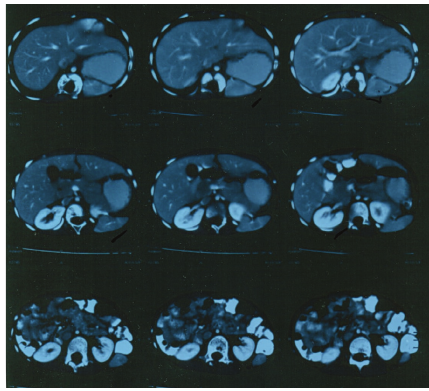
Figure 3: CT scan showing severely hypoplastic posterior abdom- inal muscles (erector spinae, iliocostalis, and latissimus dorsi) causing posterolateral herniation of the spleen. D10–12 vertebral bodies are hemivertebrae.